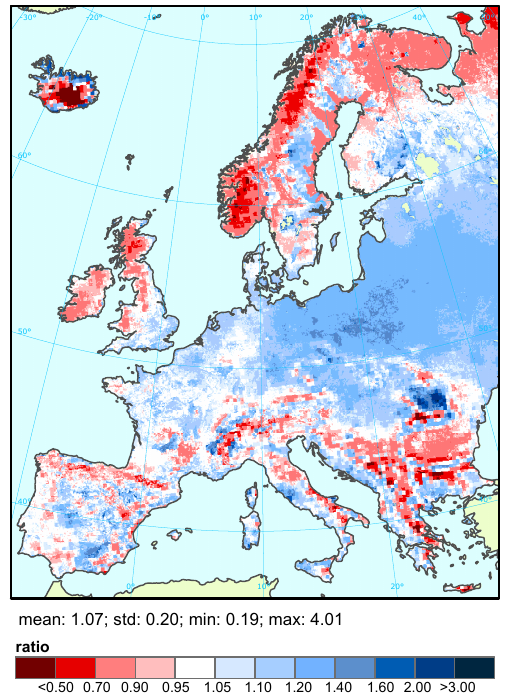
Fig. 8. Ratio for LISFLOOD evapotranspiration (mmd − 1 ) simula- tions between uncorrected and bias corrected climate data for the control period